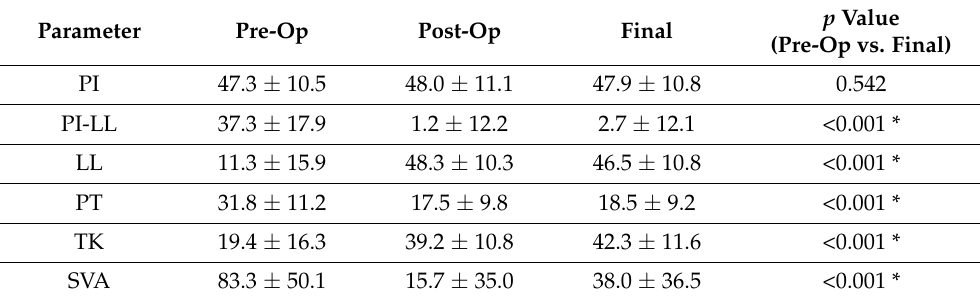
Figure 3. Correlation between various parameters. There was a low correlation between preoperative and postoperative LL ( a ) and between preoperative PI-LL and LL change using PPS ( e ). A high corre- lation was observed between PI-LL after LLIF and postoperative PI-LL ( c ) and between preoperative PI-LL and total LL change ( d ). A moderate correlation was observed between preoperative and post- operative PI-LL ( b ) and between PI-LL after LLIF and LL change with PPS ( f ). These findings indicate that greater correction is achieved in cases of greater deformity. LL: lumbar lordosis; ∆ LL: change in LL; PI: pelvic incidence; LLIF: lateral lumbar interbody fusion; PPS: percutane- ous pedicle screw. Table 3. Spinopelvic parameters.